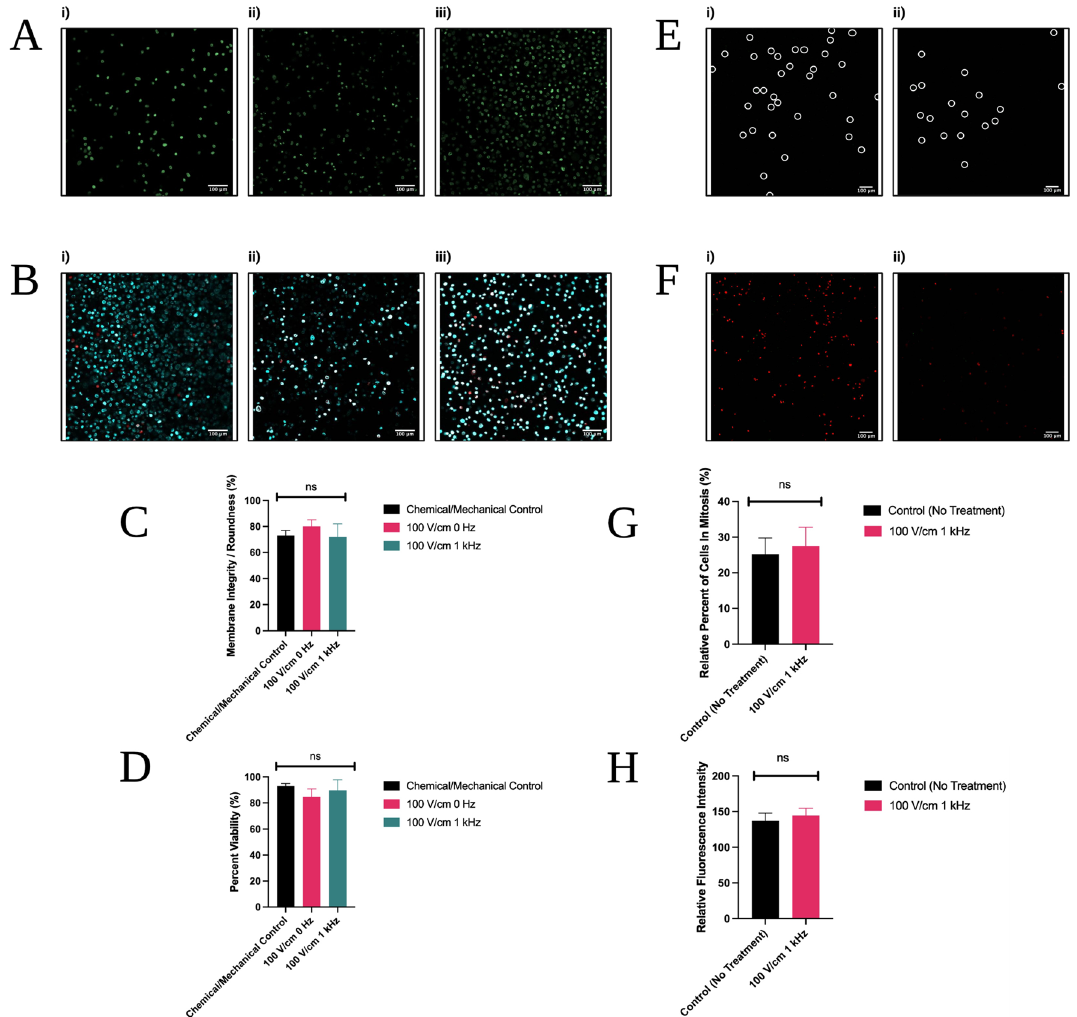
Figure 6. Human cancer cell results—quantity, viability, morphology, mitotic disruption. ( A ) Morphology images taken with a membrane permeable cell stain, Hoechst 33342. ( B ) Live/dead images taken with Hoechst 33342 as well as a membrane-impermeable dead cell stain, DRAQ7. ( Ai , Bi ) Represent samples subjected to the control chemical and mechanical treatment for 5 min. ( Aii , Bii ) Represent samples subjected to 100 V/ cm 0 Hz treatment for 5 min. ( Aiii , Biii ) Represent samples subjected to 100 V/cm 1 kHz treatment for 5 min. ( C ) Represents extracted data analysis from images, comparing the best electrical condition to the control chemical and mechanical condition in order to assess morphology ( p = 0.0755 for the control vs. 0 Hz condition, p = 0.9432 for the control vs. 1 kHz condition). ( D ) Uses the same approach to assess viability ( p = 0.1547 for the control vs. 0 Hz condition, p = 0.4520 for the control vs. 1 kHz condition). ( E ) Cells stained with Anti-Phospho Histone H3 Ser10 Antibody AlexaFluor488 conjugate. ( F ) The same interrogation region but with fluorescent signal from cells stained with both the Anti-Phospho Histone H3 Ser10 Antibody AlexaFluor488 conjugate and non-specific dye to assess total number of cells. ( Ei , Fi ) are representative images for untreated control cells, while ( Eii , Fii ) are representative images of cells treated with the best electrical condition—100 V/cm 1 kHz. The results were quantitatively analyzed ( G ) with image analysis ( p = 0.5464) and ( H ) with spectrofluorometry ( p = 0.4701). All images were analyzed using ImageJ software. Electrical results were not significantly different when compared to chemical and mechanical controls according to One-way ANOVA with Multiple Comparisons testing for ( C , D ) and Welch’s t-test for ( G , H